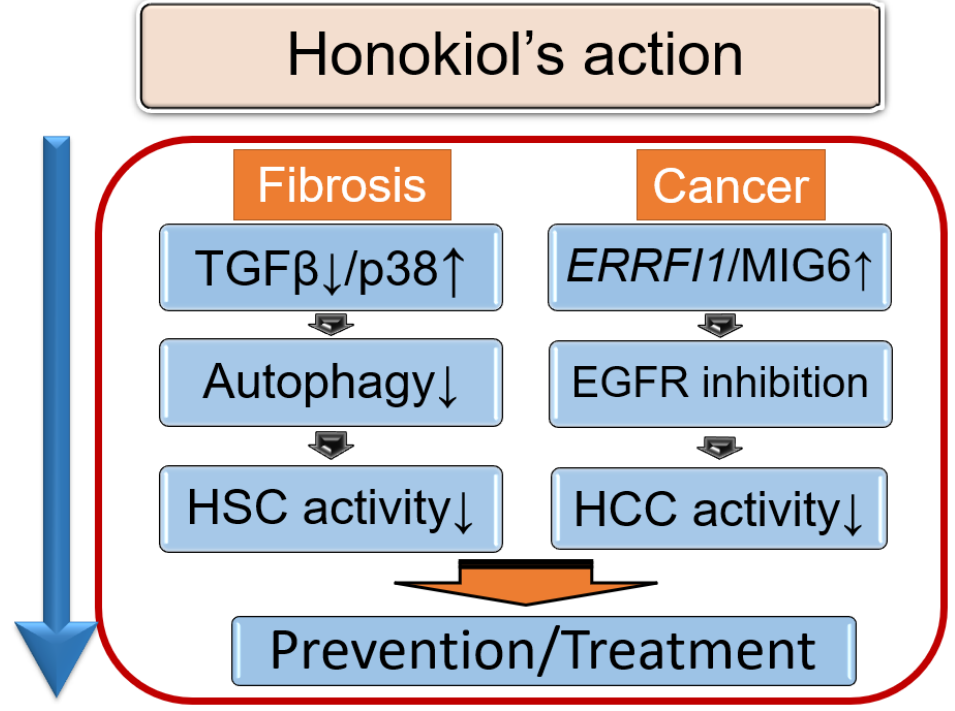
Figure 1 . The actions of honokiol . Figure 1. The actions of honokiol. A schematic model of the actions of honokiol (HNK). HNK suppresses TGF β , leading to a reduction in hepatic stellate cell (HSC) activity. In addition, HNK activates p38 and then inhibits autophagy, which also suppresses HSCs. HNK activates ERBB receptor feedback inhibitor 1 gene ( ERRFI1 ) expression, encoded by ERRFI1 , leading to EGFR inhibition in hepatocellular carcinoma (HCC). In NAFLD-afflicted livers, EGFR signaling is